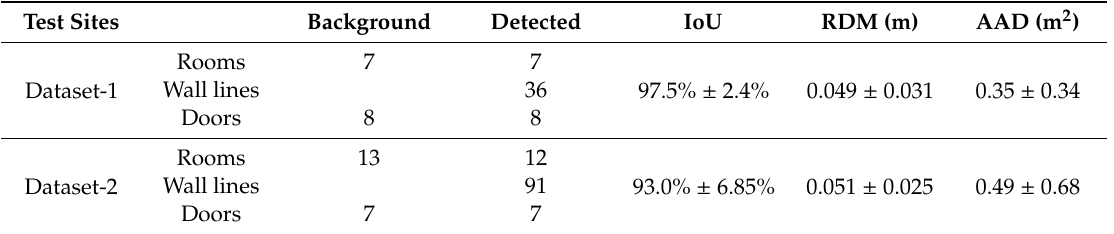
Table 2. Description of the room reconstruction evaluations using real-world datasets.